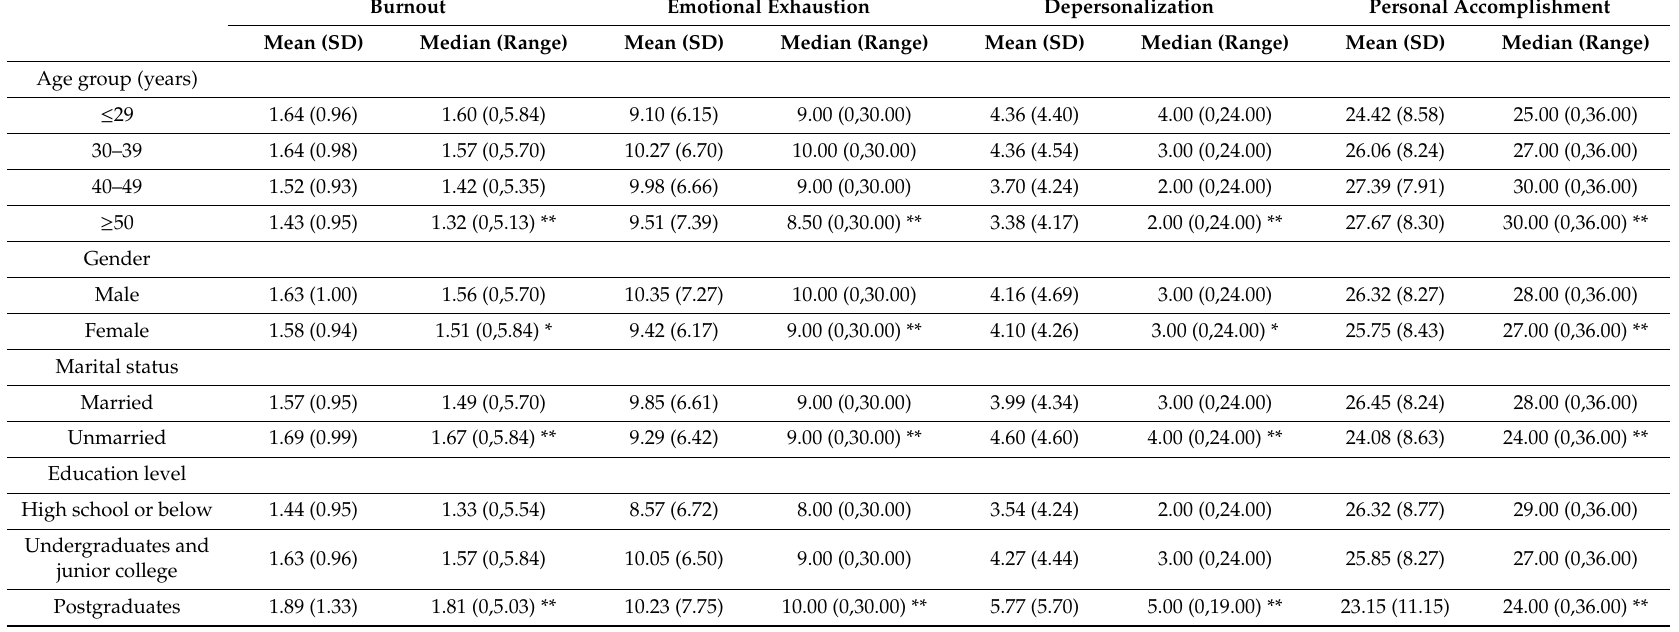
Table 4. The scores of burnout by personal characteristics and the result of bivariate